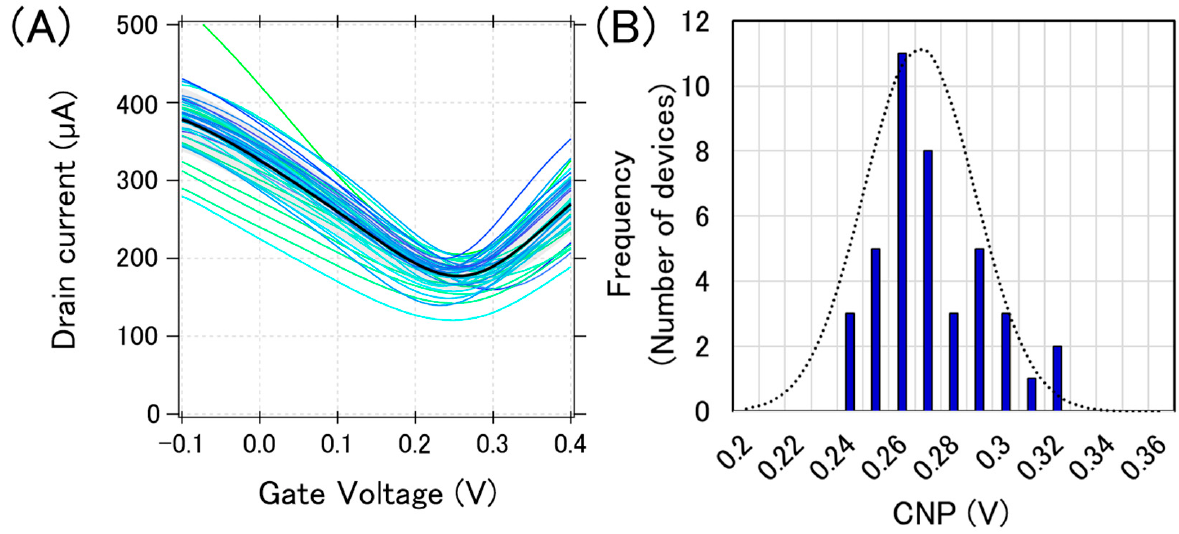
Figure 3. Initial electric characteristics of GFETs. ( A ) 40 GFET transfer curves from measurements (blue or green lines) and the calculated average curve (black bolded line) ( B ) The histogram of the CNPs with a Gaussian distribution fitting (black dotted line).